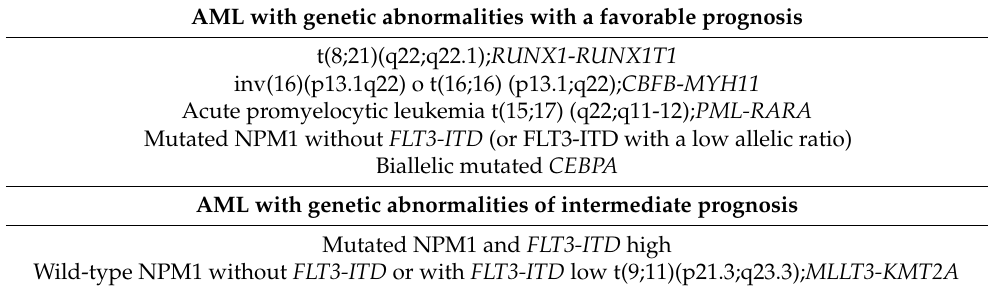
Table 4. Genetic risk of AML according to the 2017 European Leukaemia Net recommendations. Adapted from